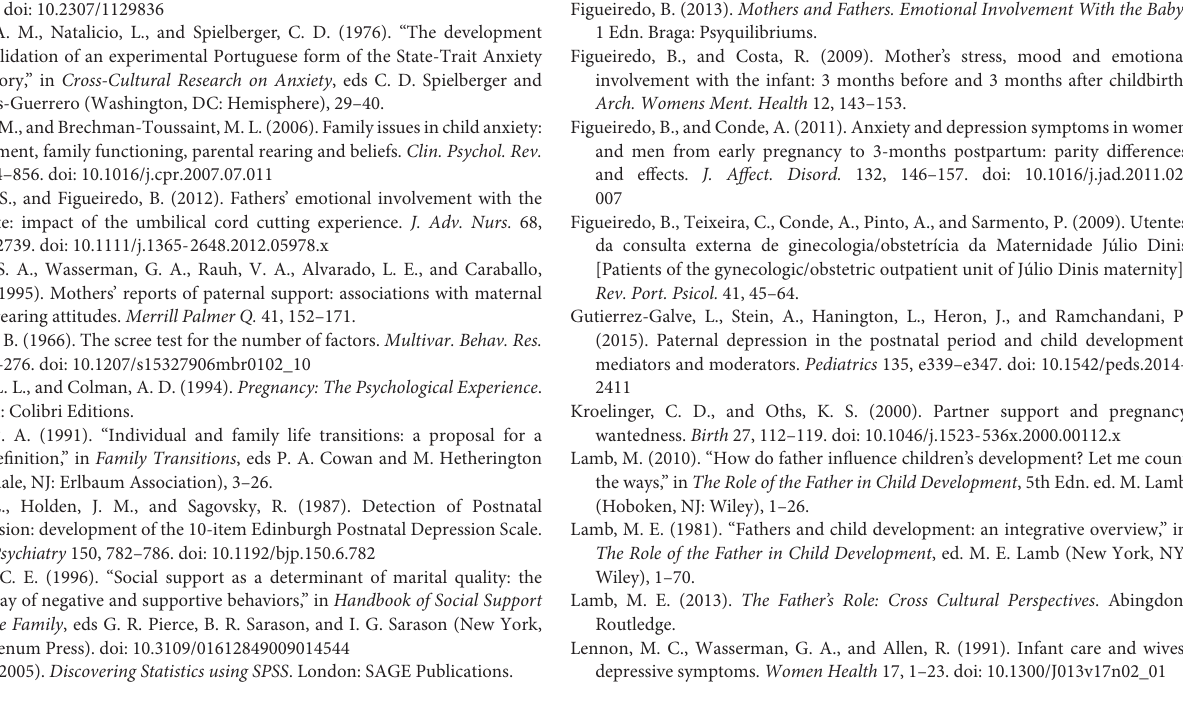
Figueiredo, B. (1997). Postpartum Depression, Mother-Infant Interaction and Child Development . Unpublished Doctoral thesis, Clinical Psychology. Braga: University of Minho. Figueiredo, B. (2013). Mothers and Fathers. Emotional Involvement With the Baby , 1 Edn. Braga: Psyquilibriums. Figueiredo, B., and Costa, R. (2009). Mother’s stress, mood and emotional involvement with the infant: 3 months before and 3 months after childbirth. Arch. Womens Ment. Health 12, 143–153. Figueiredo,B.,andConde,A. (2011).Anxietyand depressionsymptomsinwomen and men from early pregnancy to 3-months postpartum: parity differences and effects. J. Affect. Disord. 132, 146–157. doi: 10.1016/j.jad.2011.02. 007 Figueiredo, B., Teixeira, C., Conde, A., Pinto, A., and Sarmento, P. (2009). Utentes da consulta externa de ginecologia/obstetrícia da Maternidade Júlio